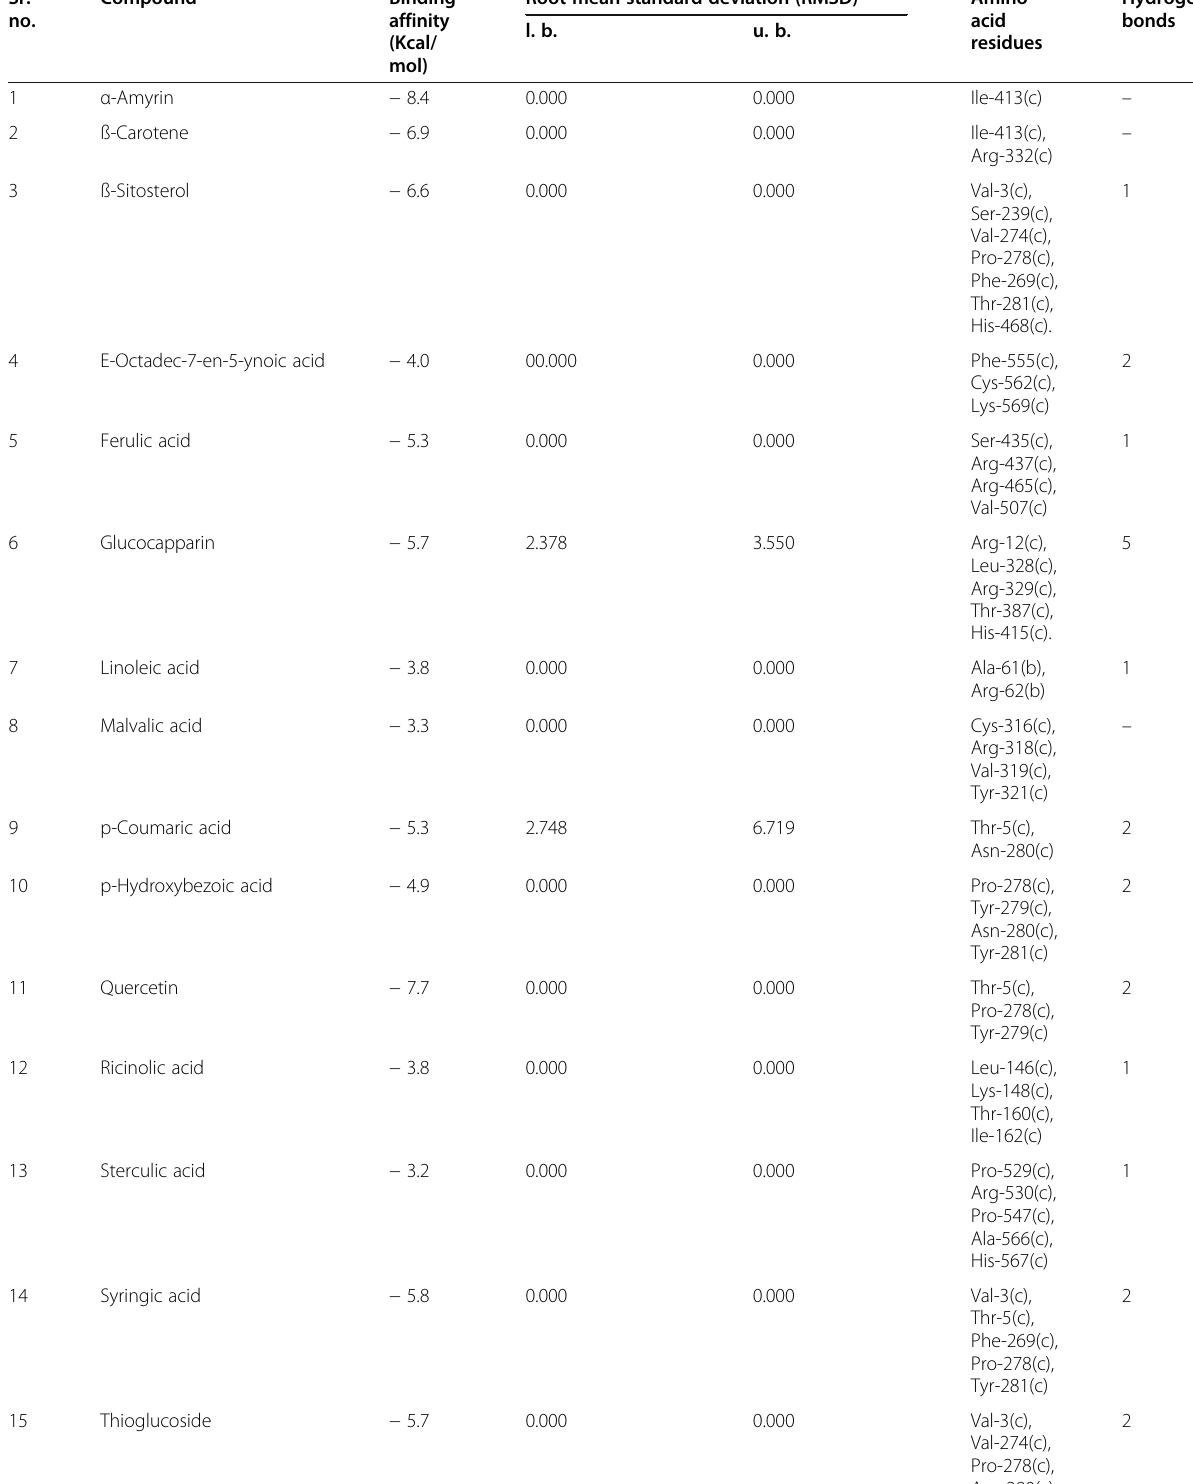
Table 2 Molecular docking studies of phytoconstituents found in C. zeylanica Linn. leaves Sr.